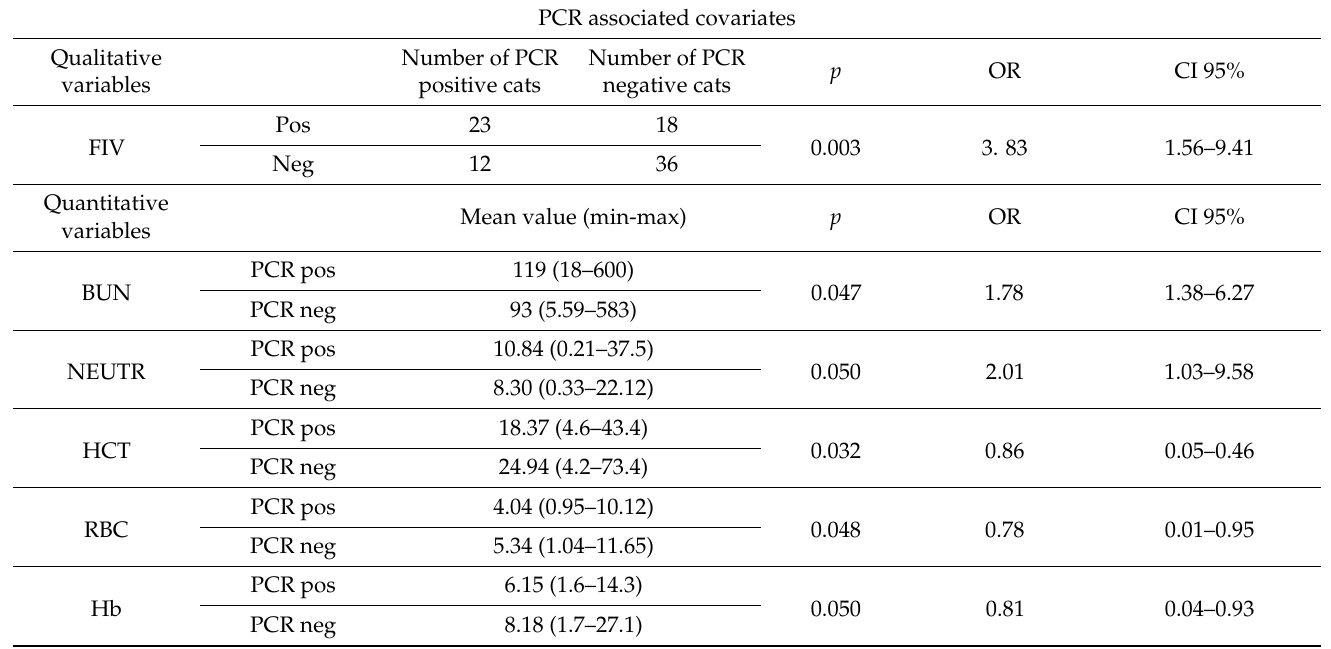
Table 2. Cont. PCR associated